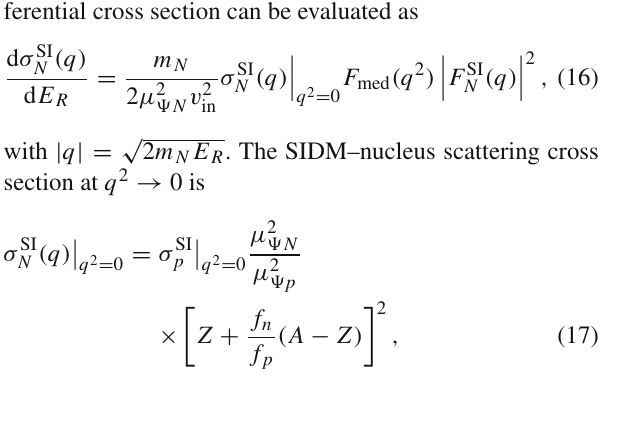
Fig. 4 The values of m φ required for given SIDM masses of m (cid:3) = 10, 30 and 39 GeV (Fig. 3). The stars are the lower bounds (orange) and upper limits (purple) of m